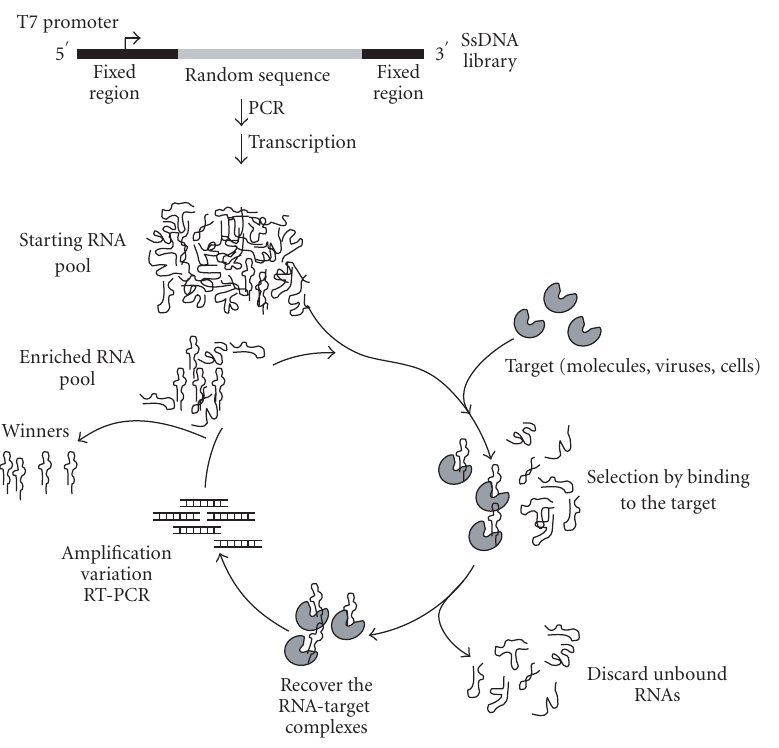
Figure 2: Schematic representation of the SELEX process. The single-stranded (ss) DNA library is amplified by polymerase chain reaction (PCR) in order to generate the double-stranded DNA pool that will be transcribed by T7 RNA polymerase. The pool of RNA molecules with di ff erent conformations will be used for the selection process (see text for